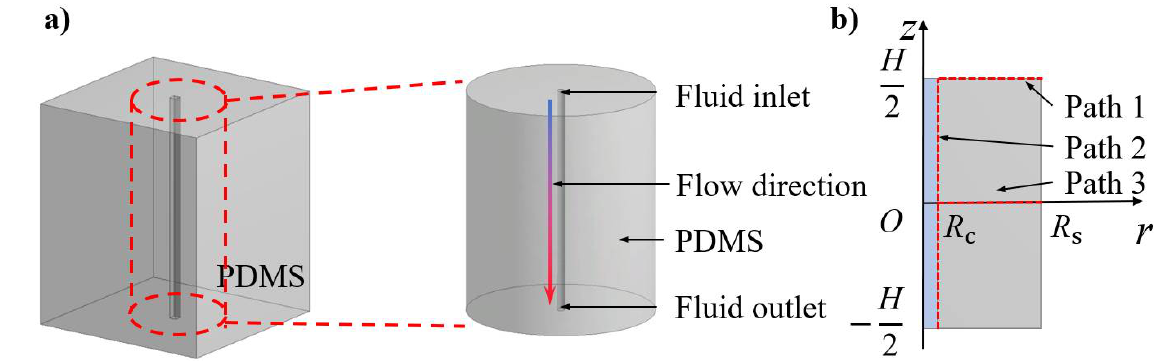
Figure 1. Schematic diagrams of ( a ) a typical active heat dissipation design with an embedded flow channel and the axisymmetric treatment of the problem, and ( b ) the theoretical model.